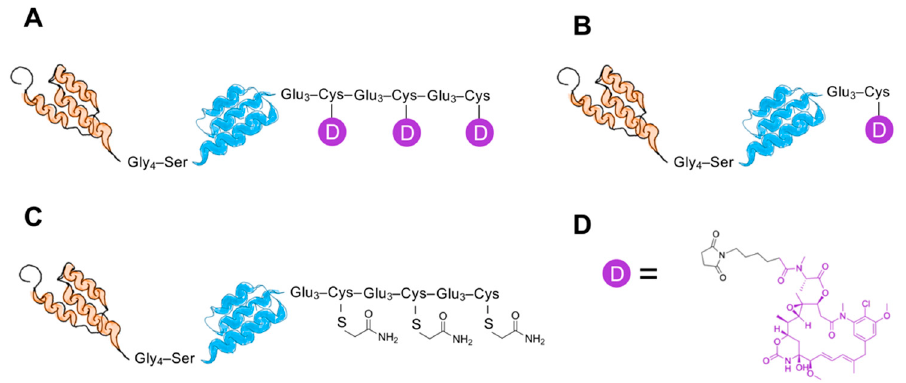
Figure 1. Schematic representation of the conjugates, Z HER2 –ABD–mcDM1 3 with drug-to-antibody ratio DAR = 3 ( A ), Z HER2 –ABD–mcDM1 with DAR = 1 ( B ), and Z HER2– ABD–AA 3 with DAR = 0 ( C ). The representations are not drawn to scale. Z HER2:2891 , a 58 amino acids human epidermal growth factor receptor 2 (HER2) binding affibody molecule, is represented as a three-helix bundle in orange. The albumin binding domain (ABD), 46 amino acids, is represented as a three-helix bundle in blue. The drug mcDM1 is represented in purple ( D ) with the maleimidocaproyl linker in black.